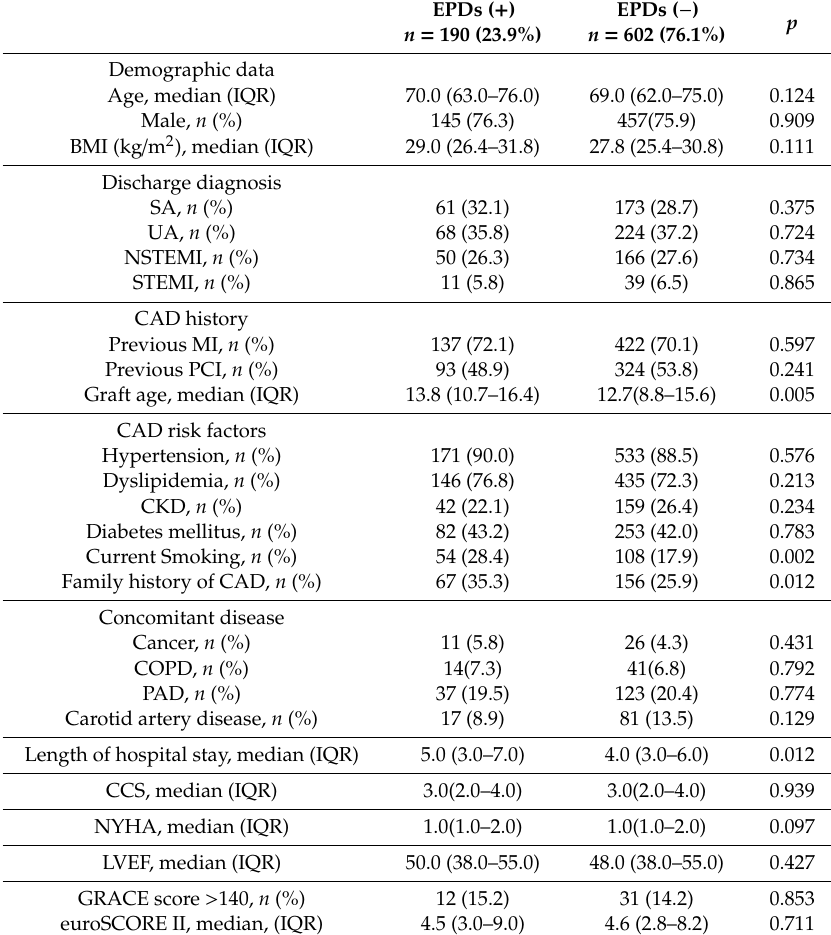
Table 1. Patients characteristics, risk factors and clinical presentation according to the use of embolic protection